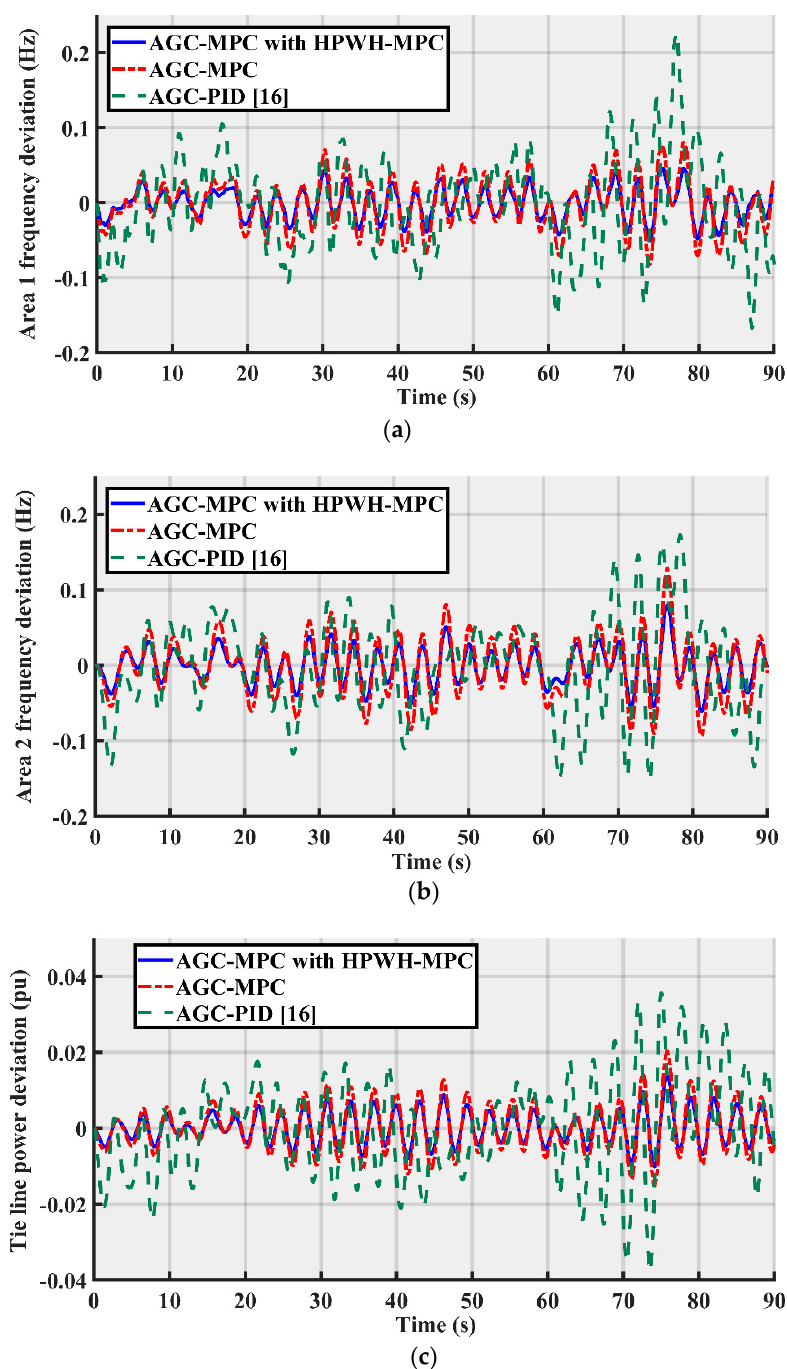
Figure 10. System performance in second scenario: ( a ) frequency deviation of Area 1, ( b ) frequency deviation of Area 2 and ( c ) tie-line power deviation.